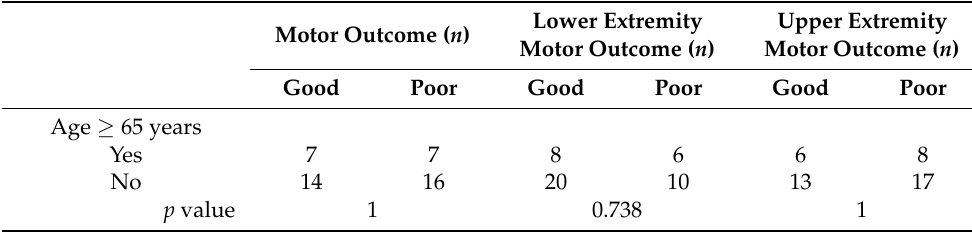
Table 4. Relationship between patient motor outcome and various parameters